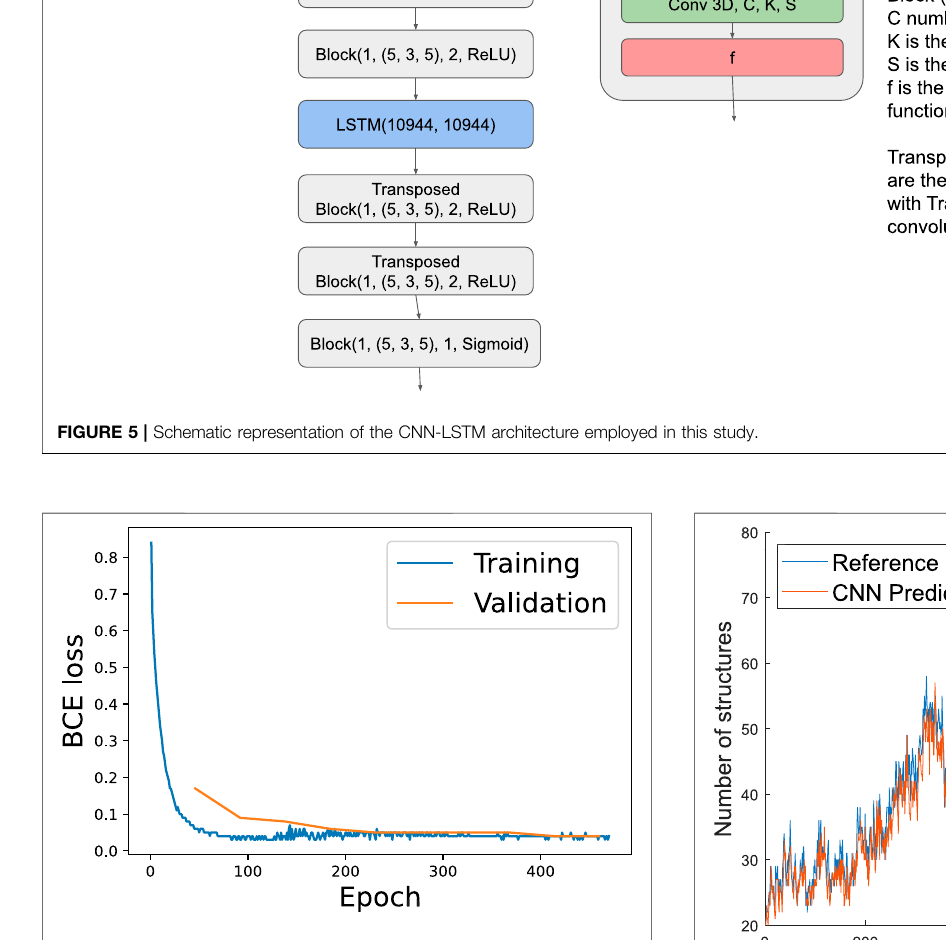
FIGURE 6 | Training and validation binary-cross-entropy (BCE) losses for the CNN architecture as a function of the training epoch.